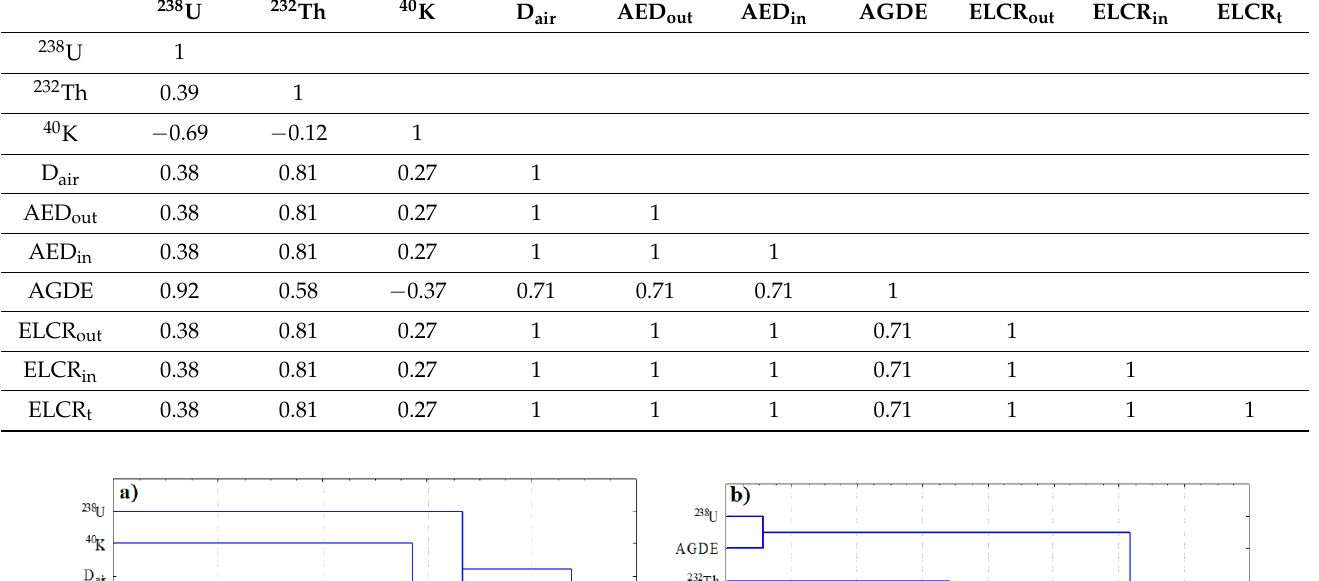
Table 7. The Pearson correlation matrix (PCM) of 238 U, 232 Th, 40 K activity concentrations and the radiological variables of quartz syenite.